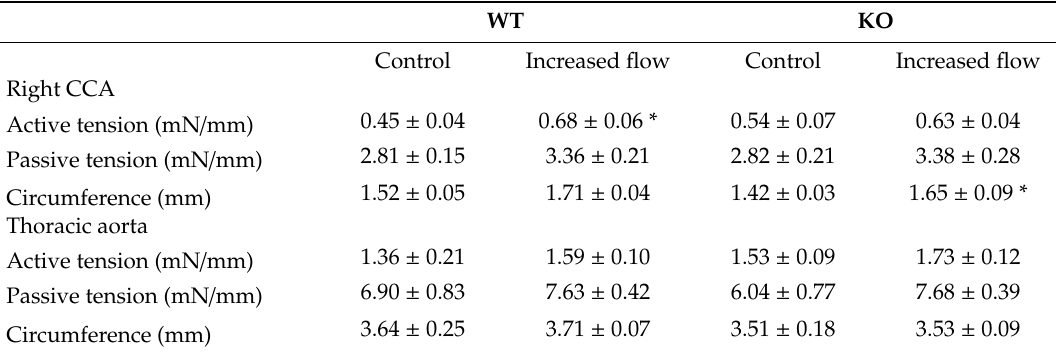
Table 2. Wire myography parameters.